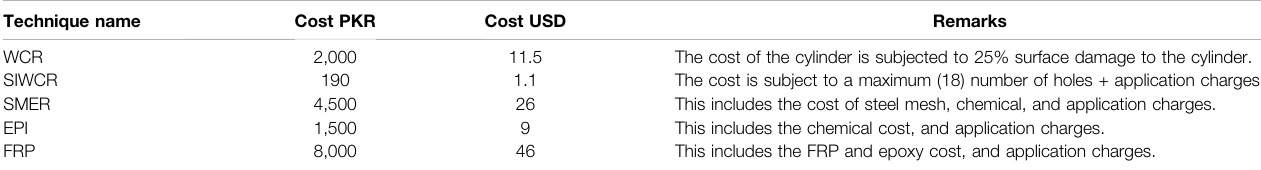
TABLE 7 | Cost comparison w.r.t. repair techniques for individual concrete